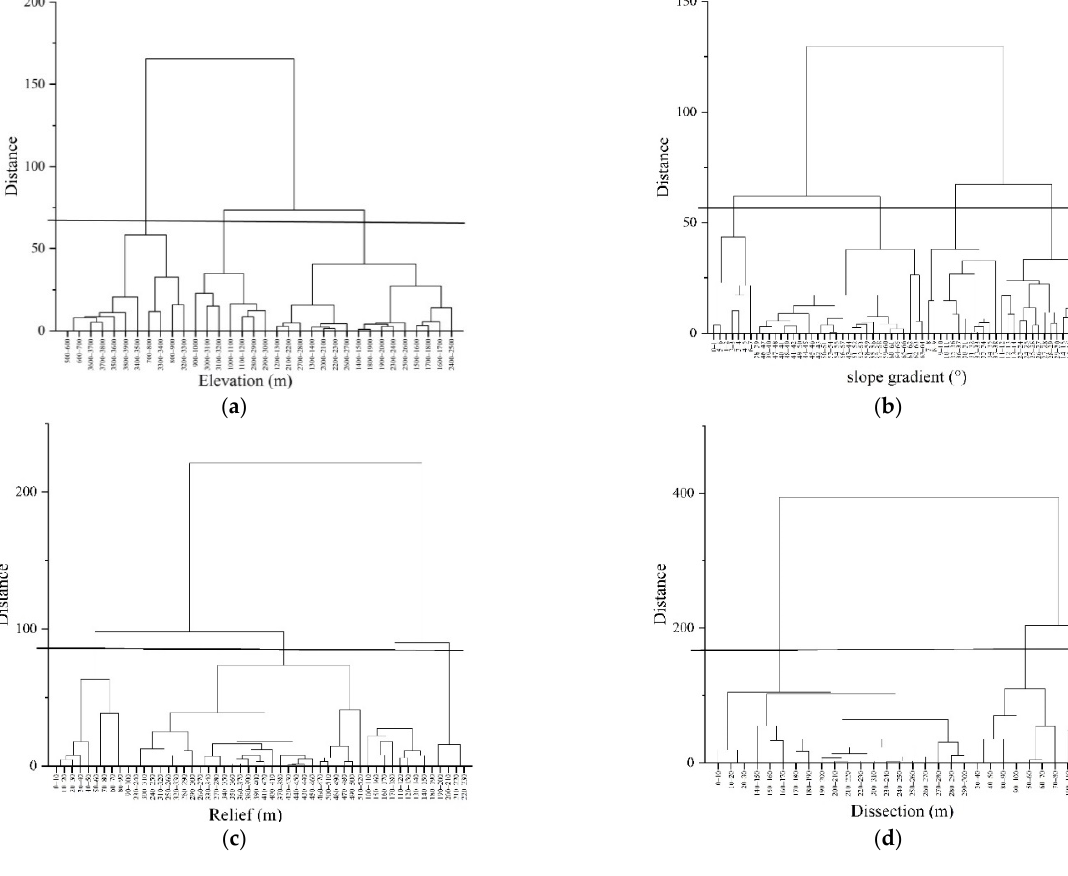
Figure 2. Tree diagram of hierarchical clustering in topographic factors. The horizontal line in the figure is the distance value for classification. The closer the distance, the more similar the gully erosion forms in the topographic range classification. ( a ) Tree diagram of hierarchical clustering in elevation; ( b ) Tree diagram of hierarchical clustering in slope gradient; ( c ) Tree diagram of hierarchical clustering in relief; ( d ) Tree diagram of hierarchical clustering in dissection.